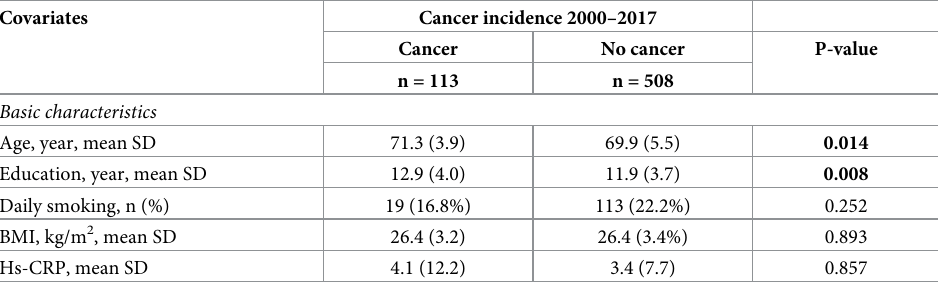
Table 1. Baseline characteristics, self-reported medical history, and health service use for incident cases of cancer and no cancer of a random sample of participants from the Oslo II-study in 2000.